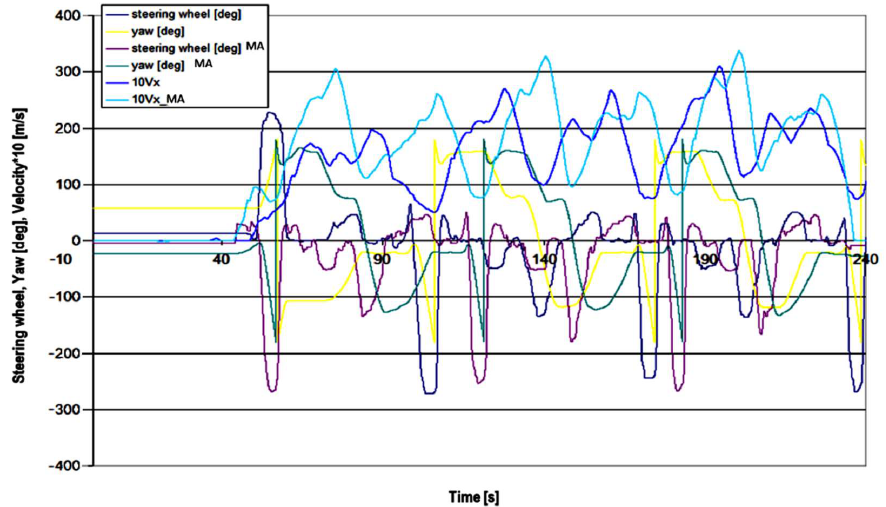
Figure 34. Parameters of the vehicle registered for minimum and maximum aerodynamic setup (MA). Steering wheel angle, yaw angle, and velocity are presented for described maneuvers. Longitudinal velocity is multiplied by 10.